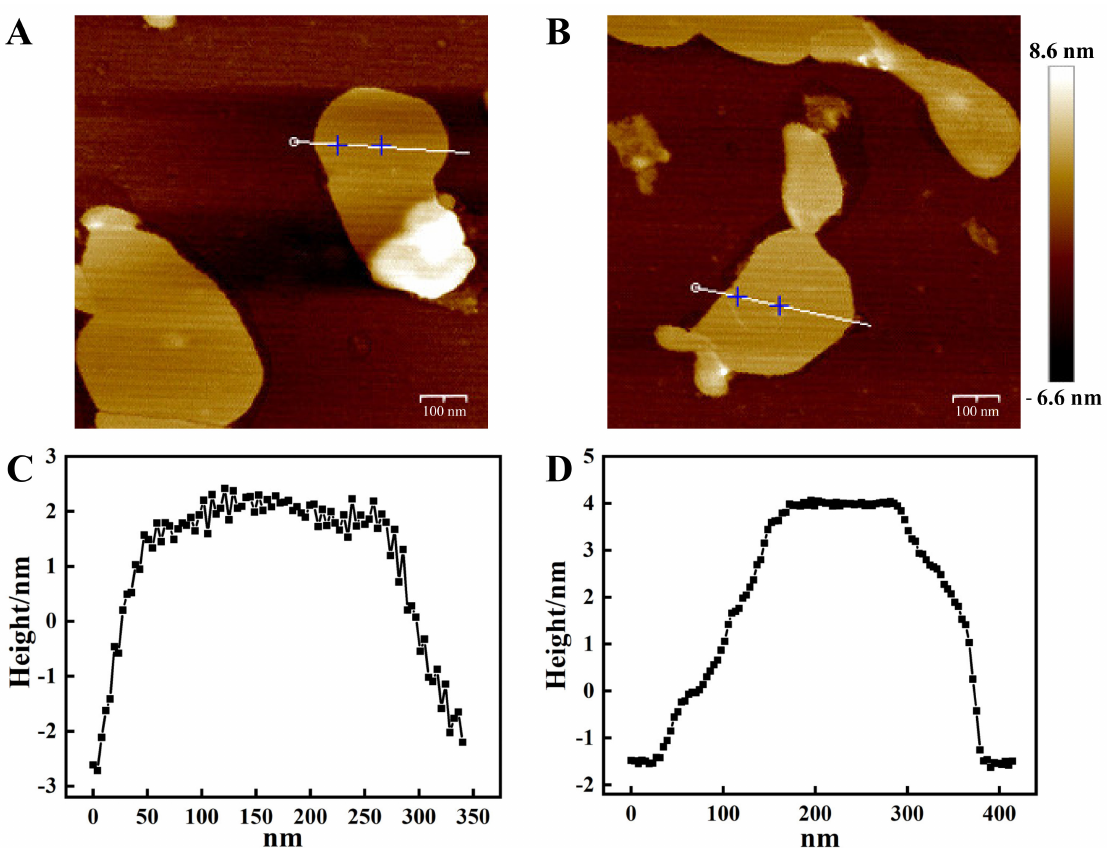
Figure 2. AFM images and height profiles of GO ( A , C ) and nanosensor ( B , D ). (Scale bar: 100